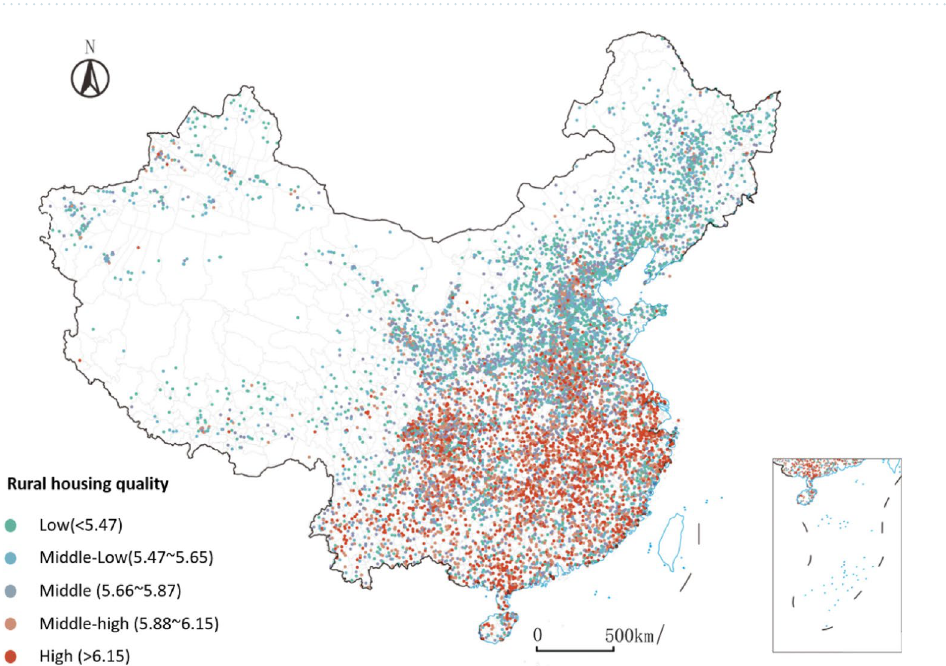
Figure 3. The distribution of predicted housing quality in rural China. Each dot represents one village. The map is created by Arcgis 10.0, and the base map is provided by Standard Map Service System (http:// bzdt. ch. mnr. gov.